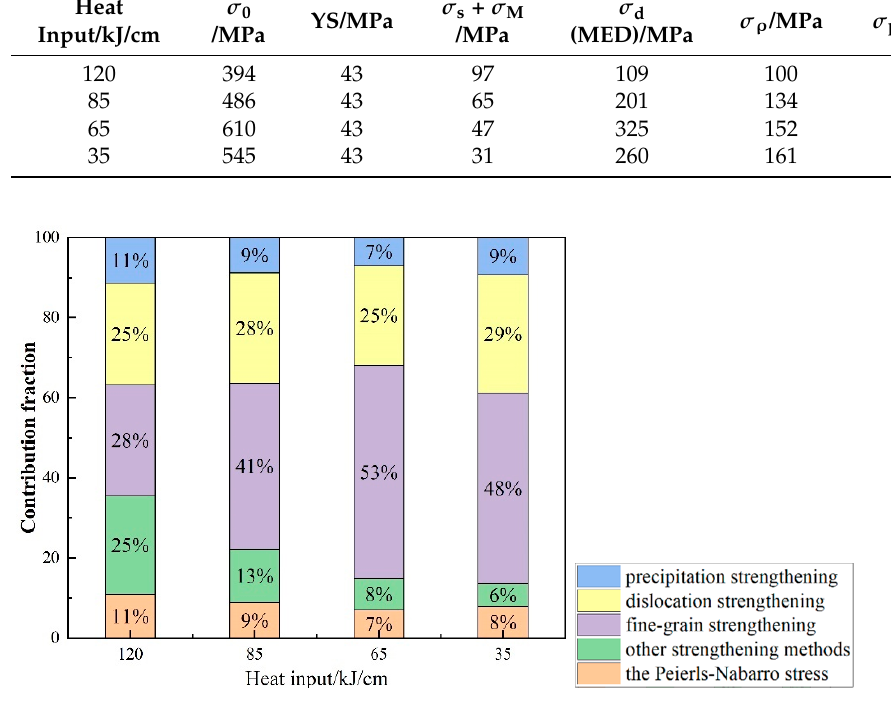
Figure 13. Contribution rate of various strengthening factors to the yield strength.